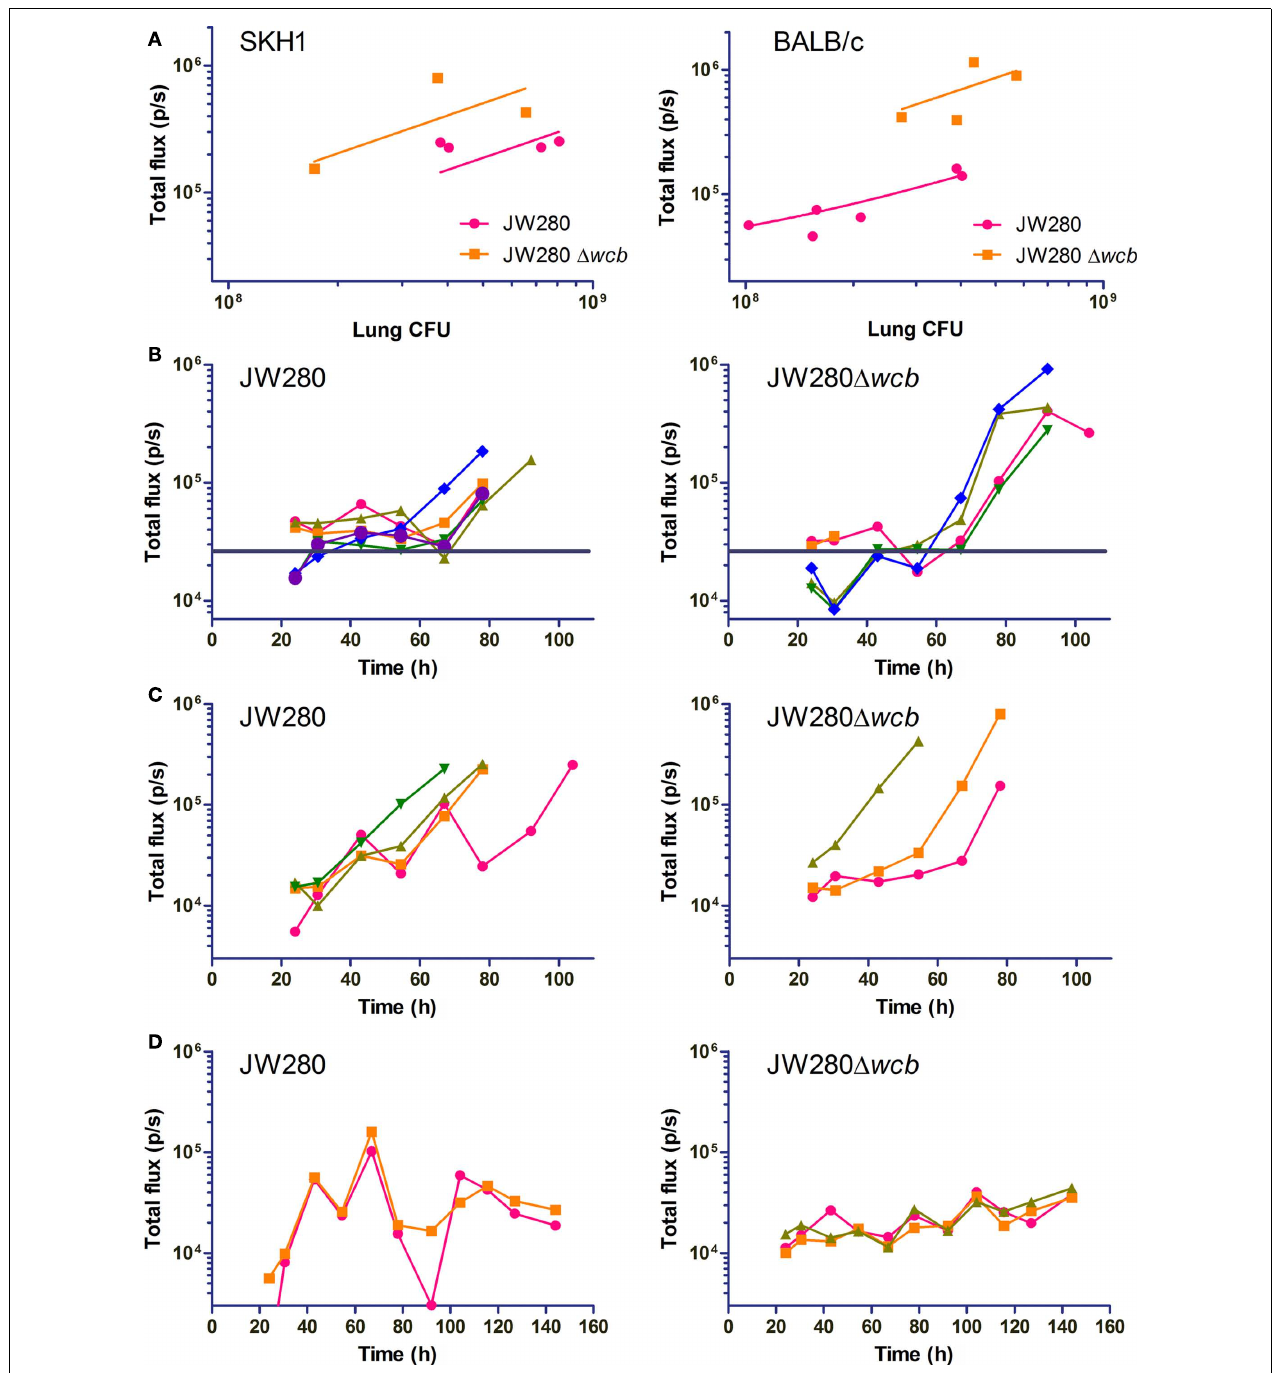
disease stage as a function of bacterial burden in the lung.The y -intercept of the trend line was constrained through the estimated noise determined from mock-infected mice. (B,C) Total flux plotted as a function of time for mice which developed morbid disease in BALB/c (B) and SKH1 (C) mice.The average noise level estimated from mock-infected mice is indicated with a horizontal bar (B) or the x -axis (C) . (D) Total flux plotted as a function of time for mice which survived the pneumonia phase of disease in SKH1 mice.The average noise level estimated from mock-infected mice is set at the x